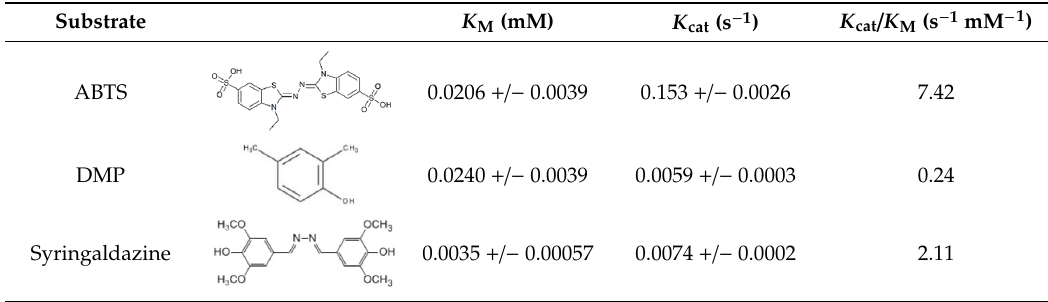
Table 3. Kinetic parameters of Sl Lac2.